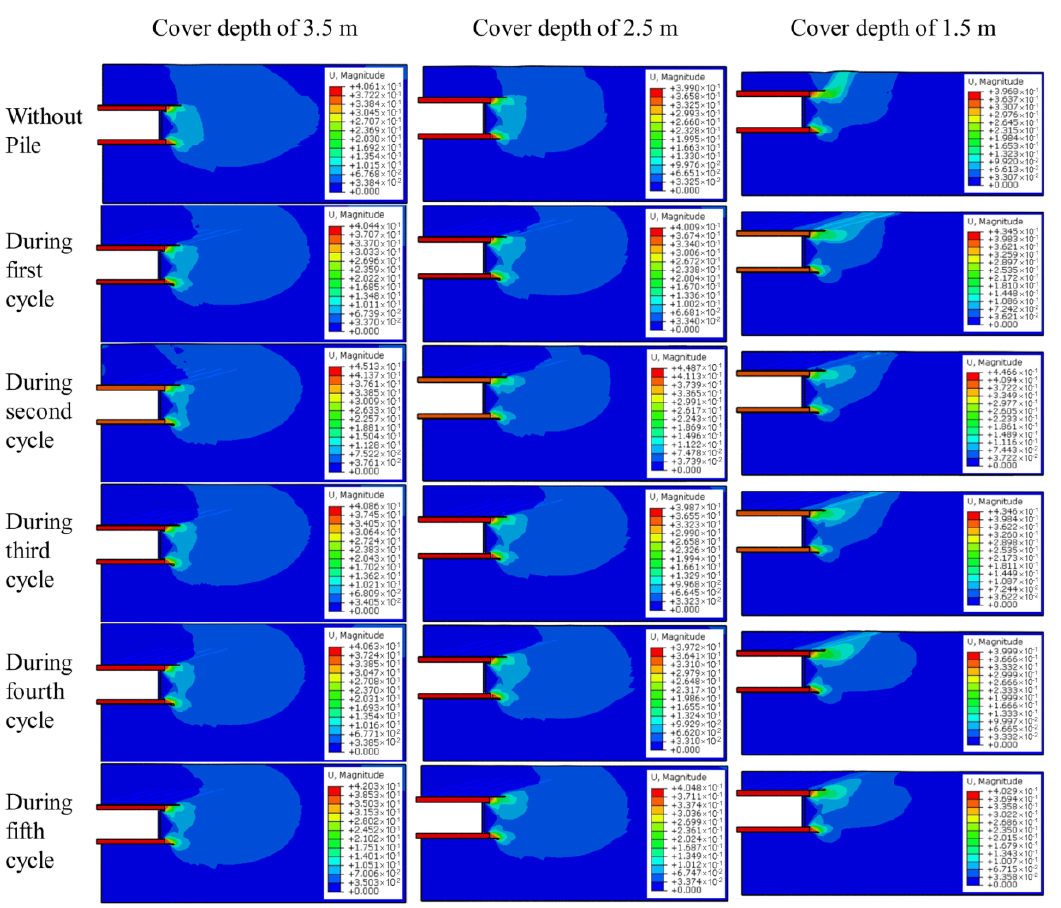
Figure 21. Ground displacement during Stage 2 of each construction cycle.